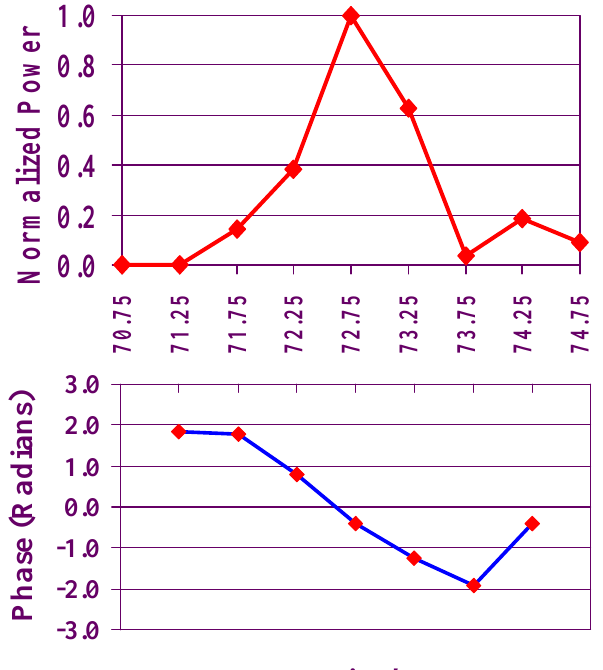
Fig. 5. Latitude dependent power and phase for the 2.5mHz FLR seen in Fig. 3. The power is the square of the Fourier amplitude, and the phase is estimated from the ratio of the imaginary and real Fourier component at 2.5mHz.